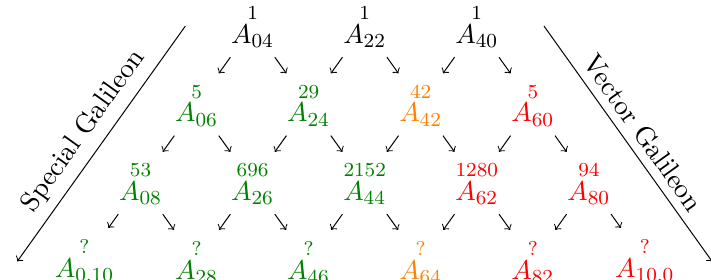
, where Figure 1 . The web of the amplitudes and the contact terms. We use the notation A # n γ n ϕ is either the set of contact terms (# is their number), or the amplitude. Whenever two nodes A n γ n ϕ of the web can be connected by an oriented path, the contact terms corresponding to the starting point of the path contribute to the amplitude attached to the endpoint of the path. Provided the theory exists, the green-colored amplitudes can be uniquely reconstructed recursively from the O ( p 3 ) soft limit alone, the red-colored ones should be fixed by some additional requirements. The orange-colored amplitudes A could be reconstructed using just one such extra n ϕ +2 ,n ϕ